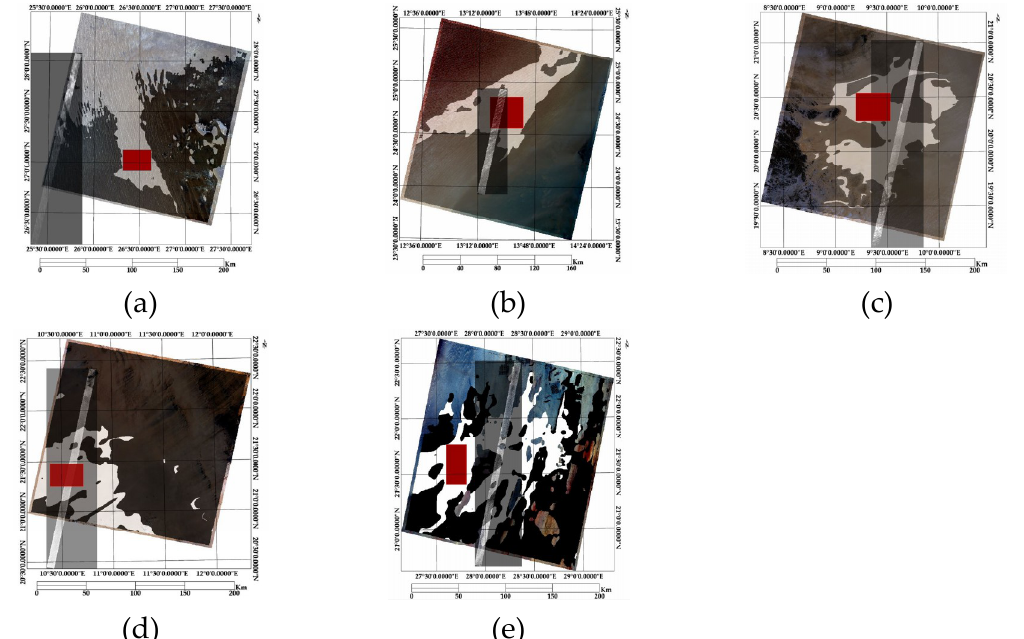
Figure 1. South Dakota State University (SDSU) identified standard region of interest (ROI) and optimal region of Pseudo-Invariant Calibration Site (PICS); ( a ) Egypt 1 (27.41°N, 26.38°) ; ( b ) Libya 1(24.70°N, 13.49°E); ( c ) Niger 1(9.36°N, 20.41°E); ( d ) Niger 2(10.44°N, 20.8°E); ( e ) Sudan 1 (21.40°N, 27.70°E) .